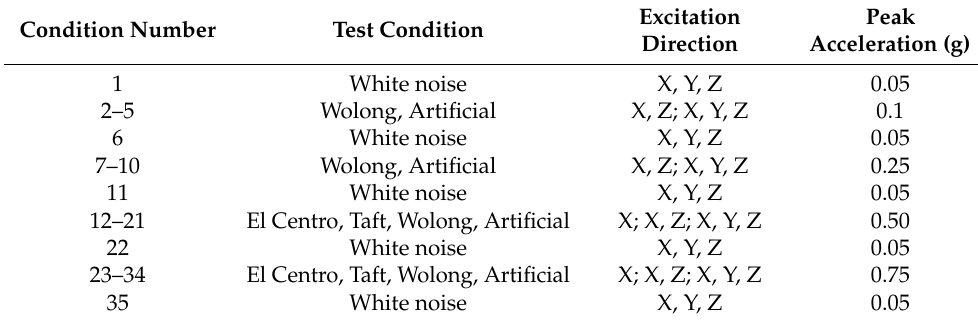
Table 1. Arrangement of test conditions.